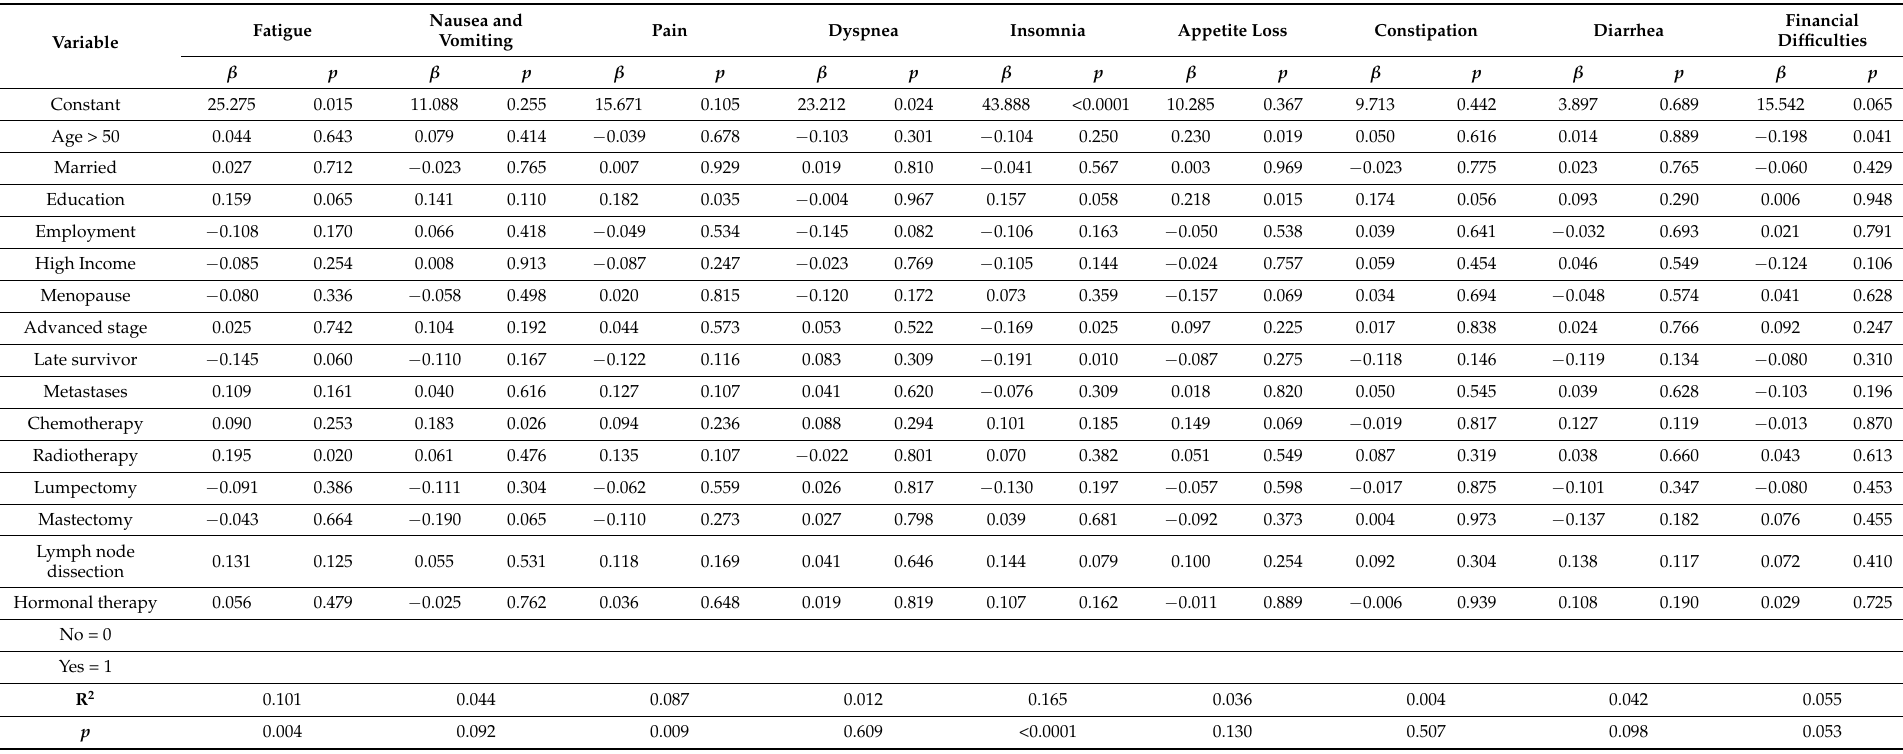
Table A1. Linear regression model with parameter estimates for the QLQ − C30 symptom